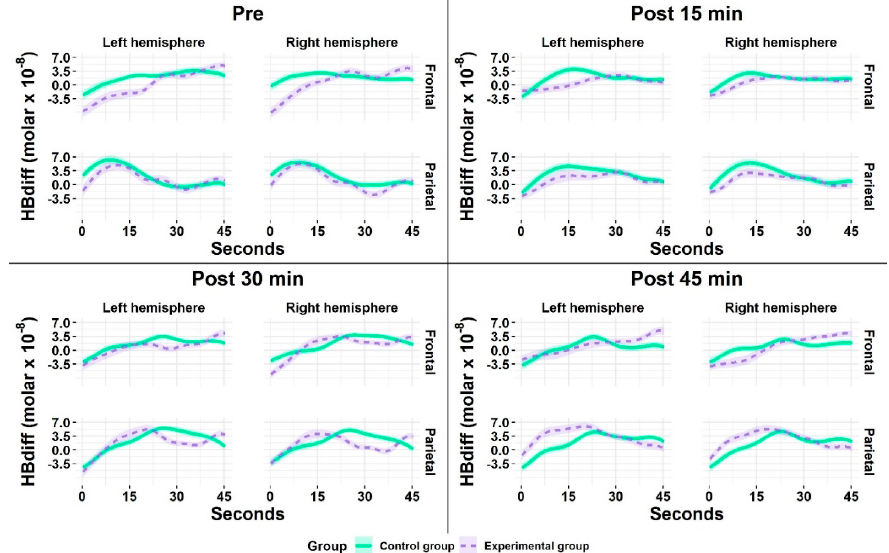
Figure 7. Mean cortical hemodynamic activity as measured by HBdiff during the 2-back task for the experimental (EG) and control group (CG) at the time point pre (baseline) and at the follow-up measurements after the acute exercise intervention (EG) or listening to the audiobook (CG), respectively. All values are given as mean ( M ); the colored frames on the curves correspond to one standard error ( SE ) of the mean.